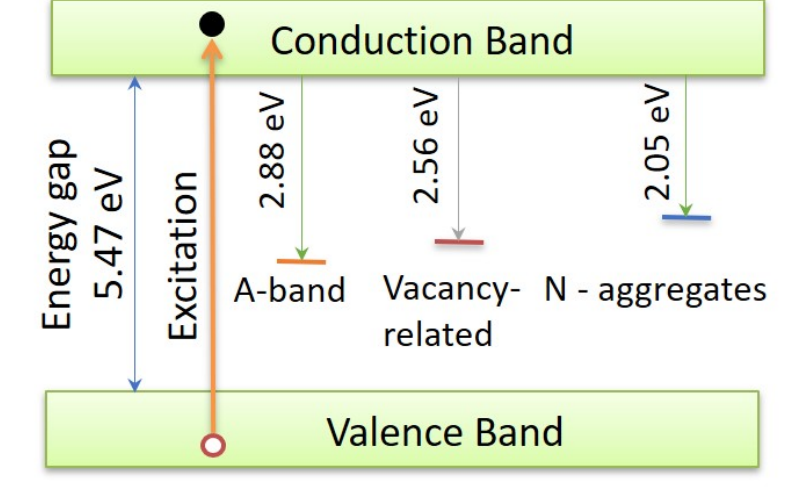
Figure 7. The scheme of radiative recombination centers in the band gap of CVD